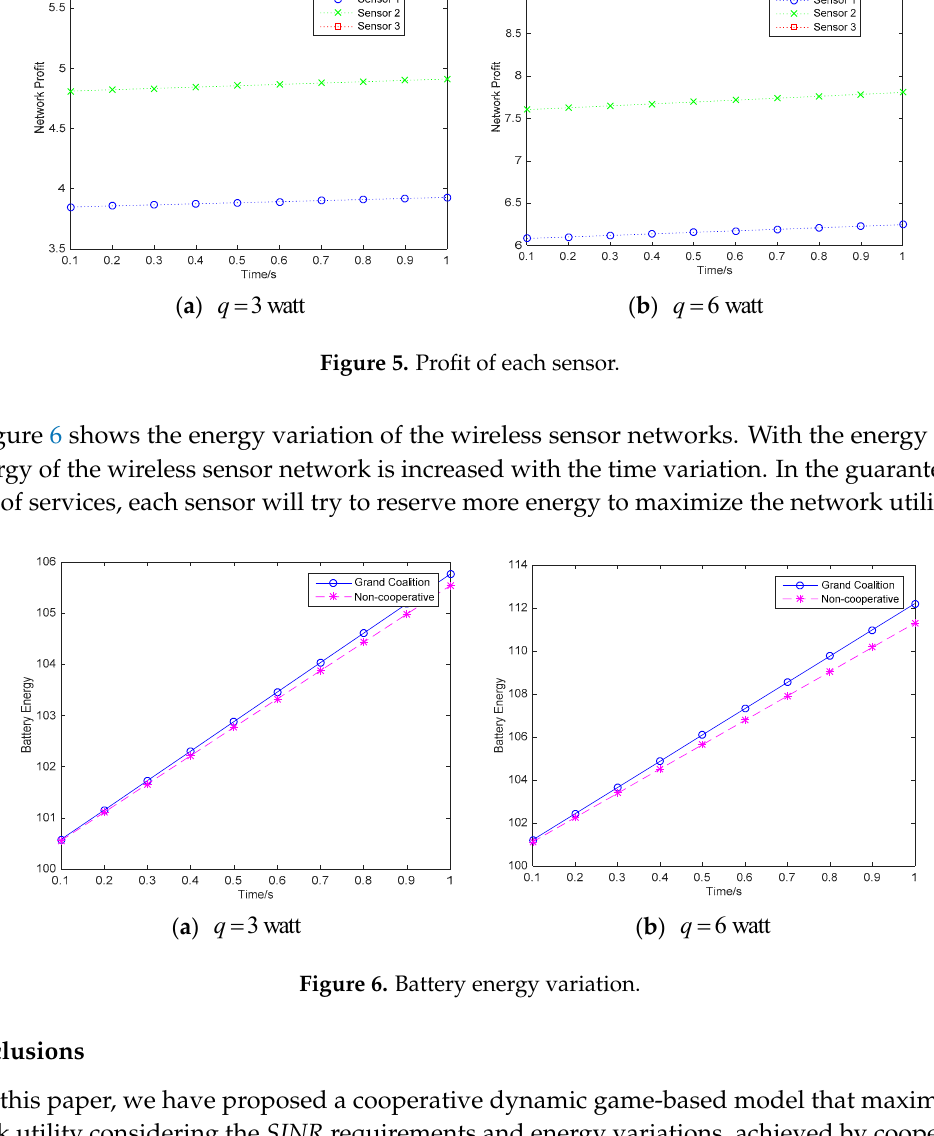
Figure 4. Network profit.